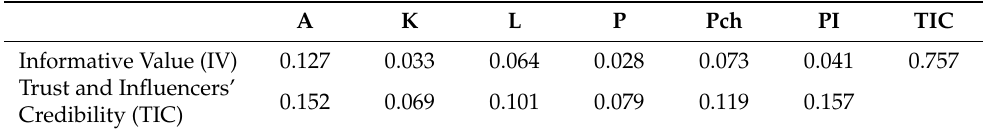
Figure 2. Partial least squares (PLS) path model. Table 7. Effect size f 2